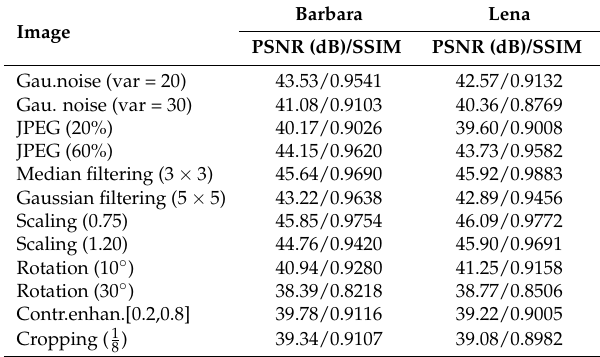
Table 1. Performance results of the Barbara and Lena images against common attacks.